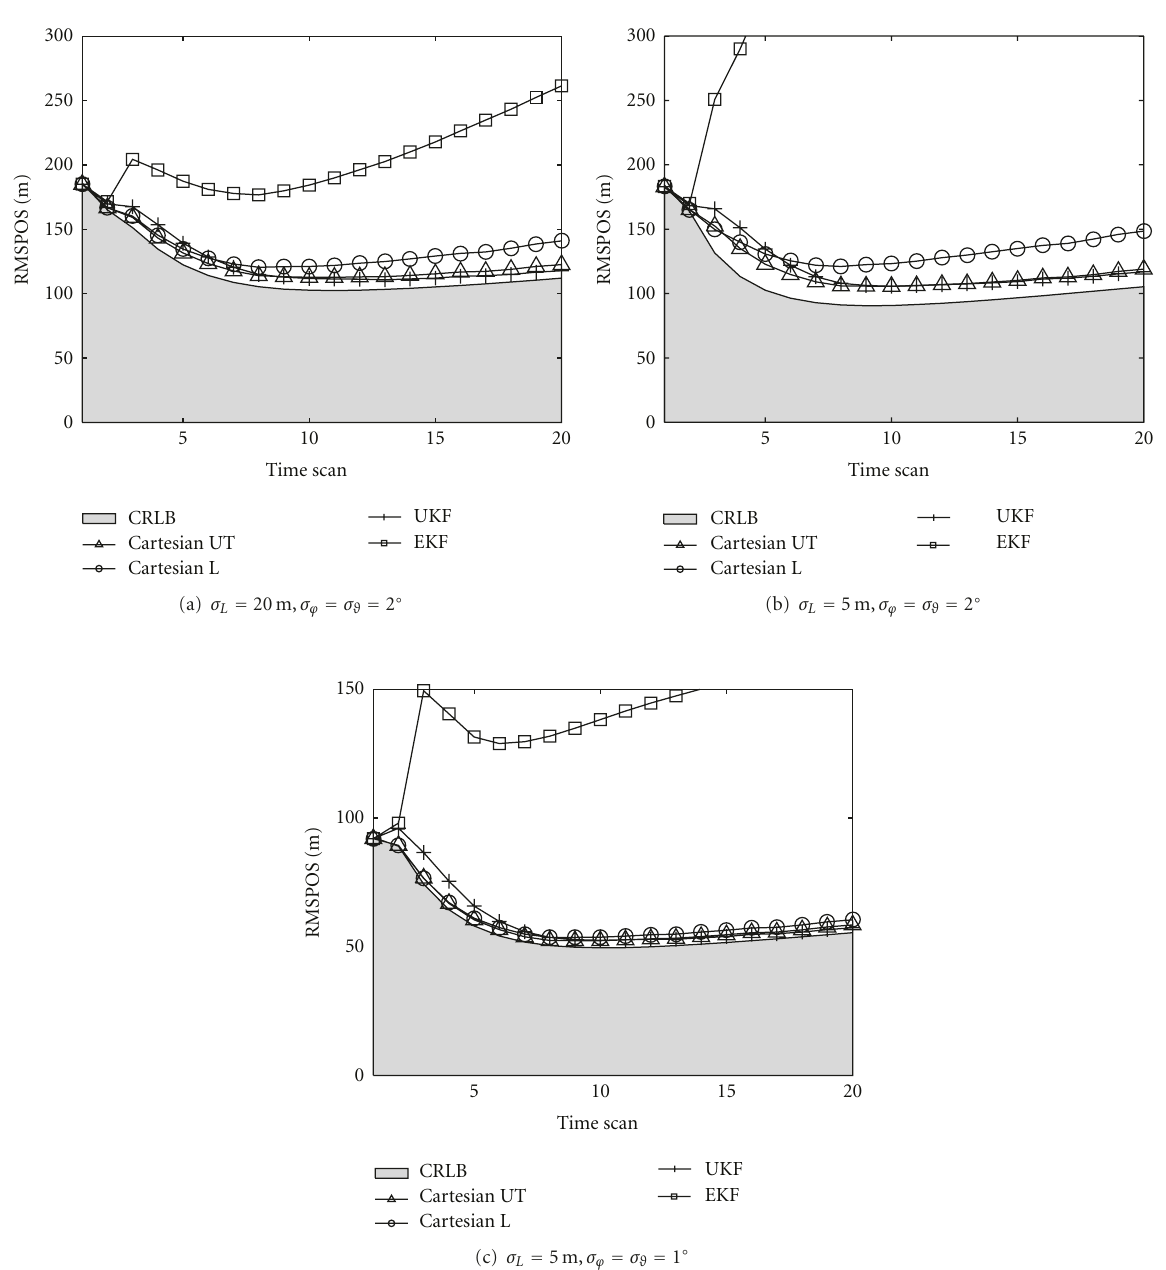
Figure 18: Comparison of di ff erent types of Kalman filters: In (a) the standard setting was used; (b) and (c) illustrate results for modifications in bearing and sensor precision. The EKF shows the worst tracking performance.